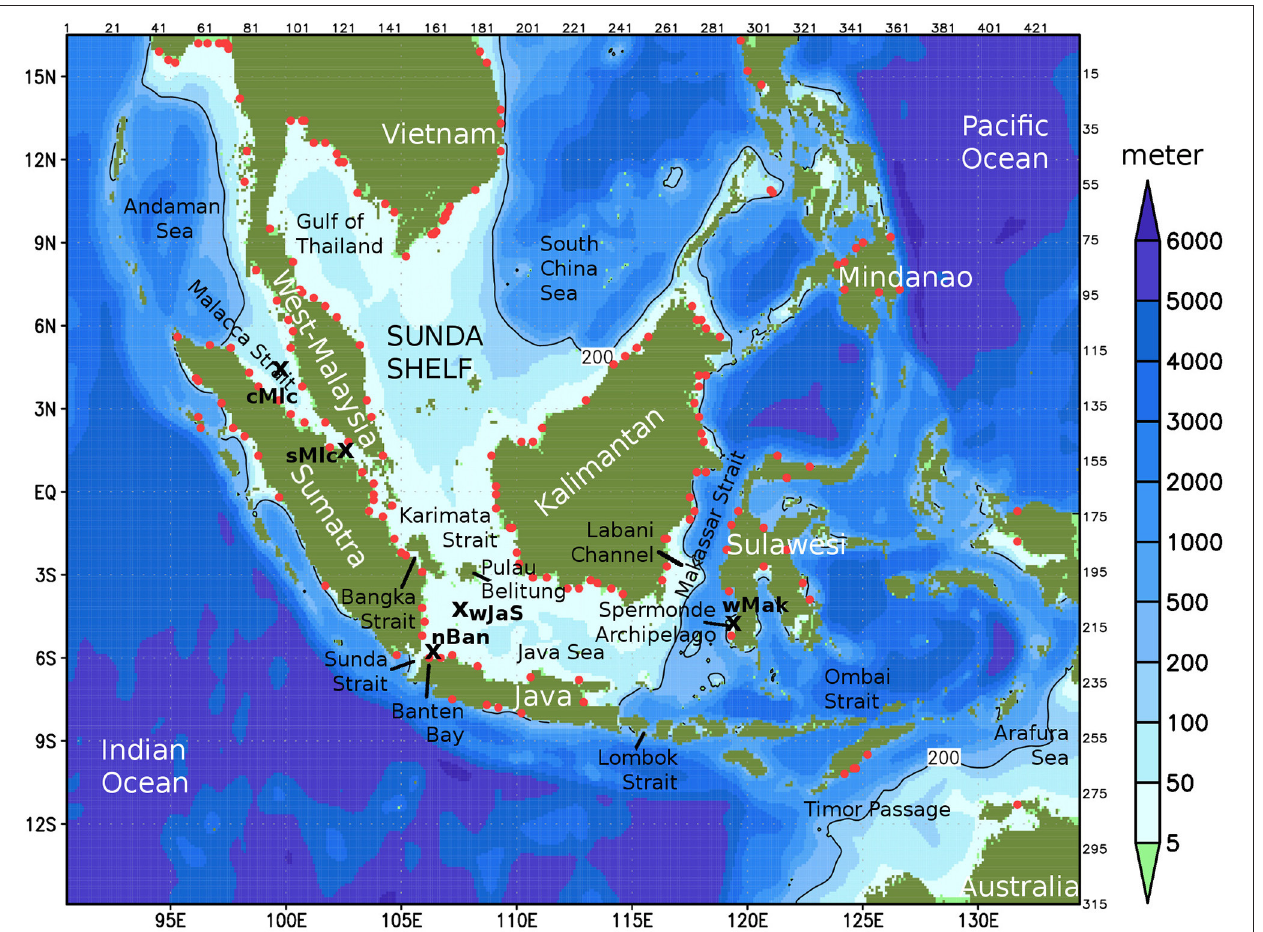
FIGURE 1 | Regional hydrodynamical model domain with bathymetry. Red dots: river input points; X: locations to show single point time series of simulated carbonate system data. Isobath of 200 m is also drawn to depict the Sunda Shelf limit. Along the upper and right axes, model grid indices are shown.